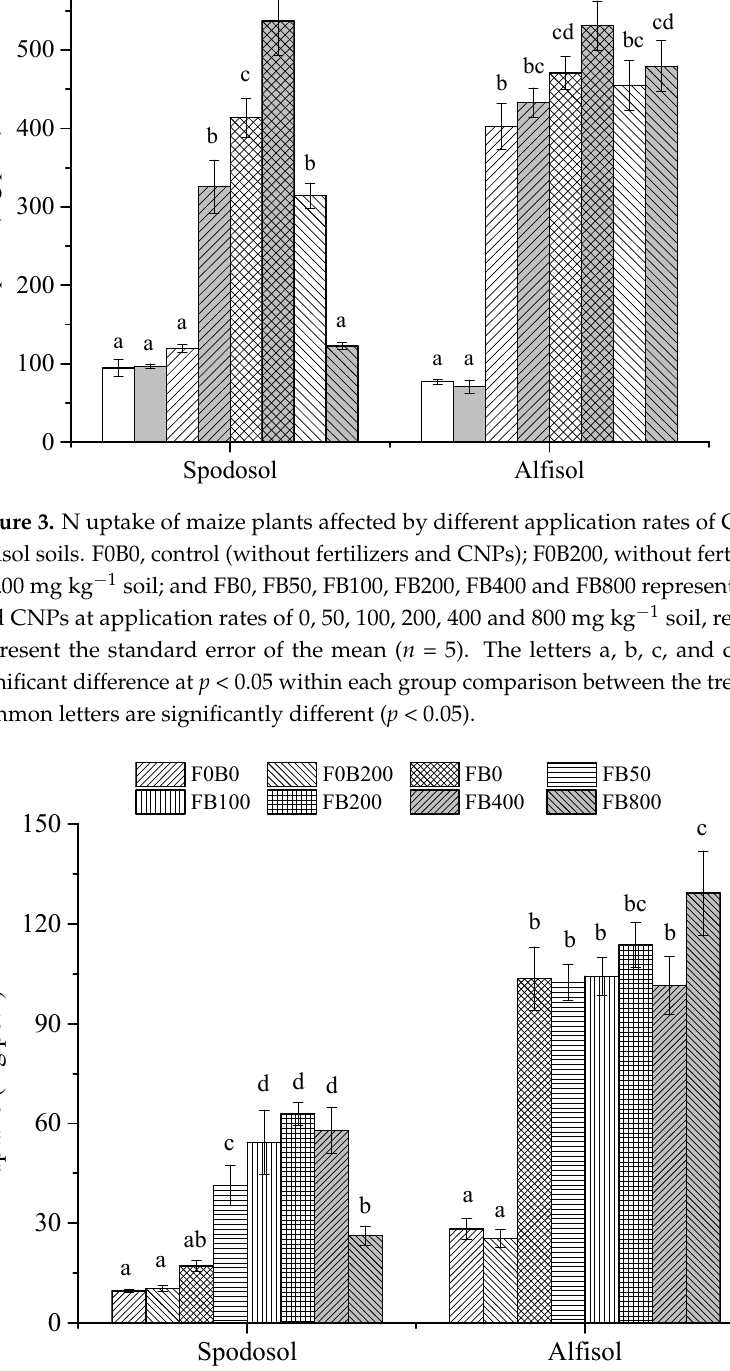
Figure 4. P uptake of maize plants affected by different application rates of CNPs in Spodosol and Alfisol soils. F0B0, control (without fertilizers and CNPs); F0B200, without fertilizers and with CNPs at 200 mg kg − 1 soil; and FB0, FB50, FB100, FB200, FB400 and FB800 represent those with fertilizers and CNPs at application rates of 0, 50, 100, 200, 400 and 800 mg kg − 1 soil, respectively. Error bars represent the standard error of the mean ( n = 5). The letters a, b, c, and d indicate statistically significant difference at p < 0.05 within each group comparison between the treatments. Bars with no common letters are significantly different ( p < 0.05).